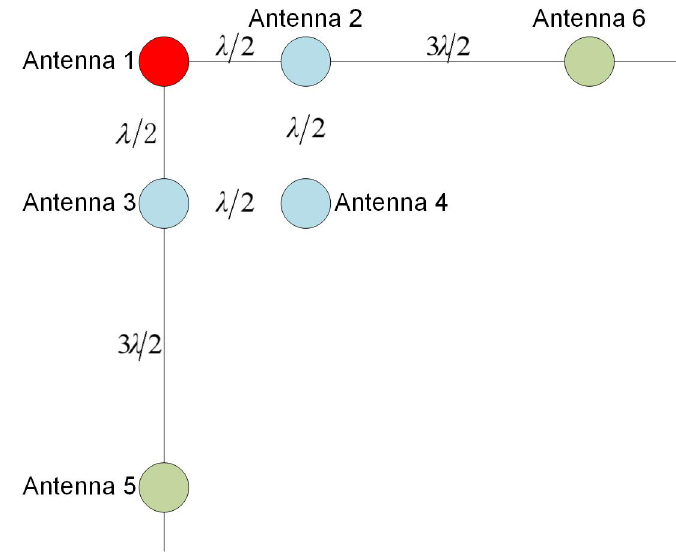
Figure 6. Array antenna configuration.